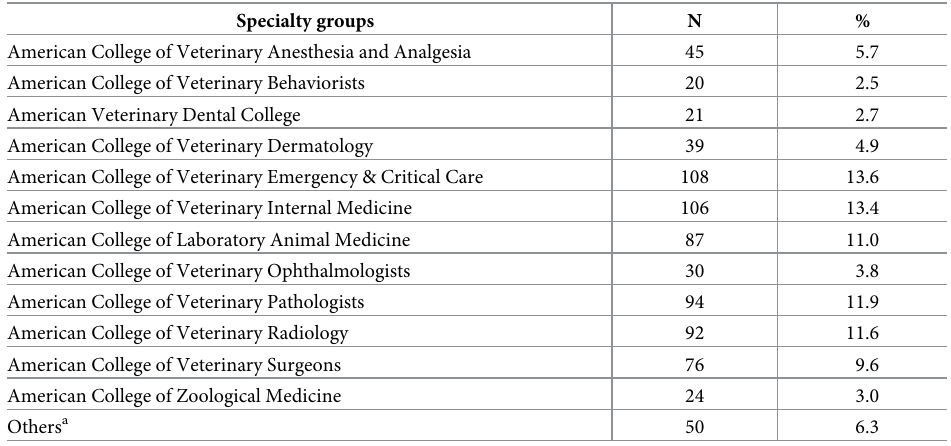
Table 1. Veterinary residency specialty groups and distribution in the study population (N = 792). Specialty